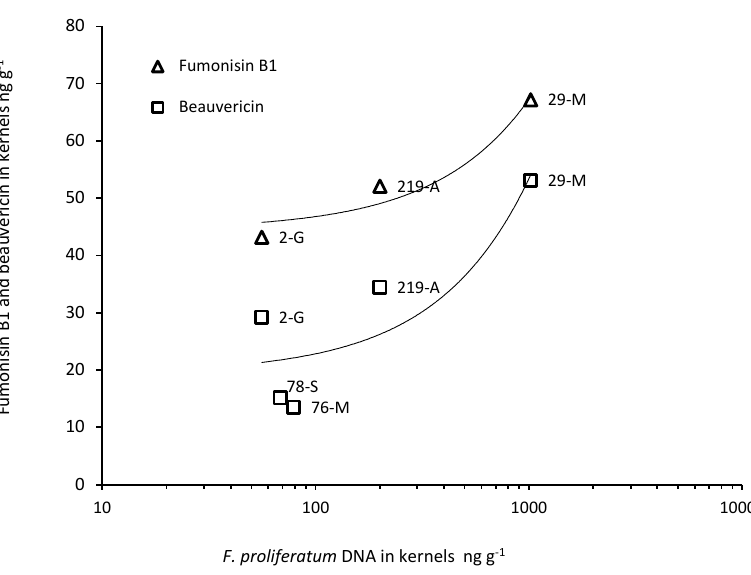
Fig. 5. Correlation of mycotoxin accumulation and amount of F. proliferatum DNA in wheat kernels